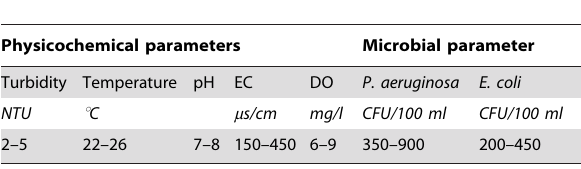
Table 1. Reference values of stored rainwater